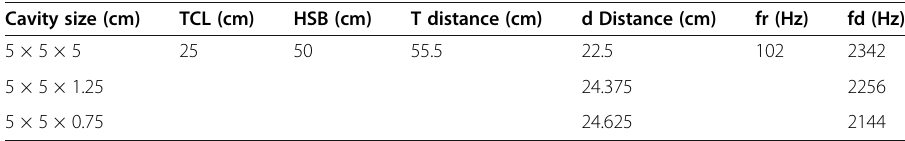
Table 4 Summary of the FE results analytical analysis Cavity size (cm)